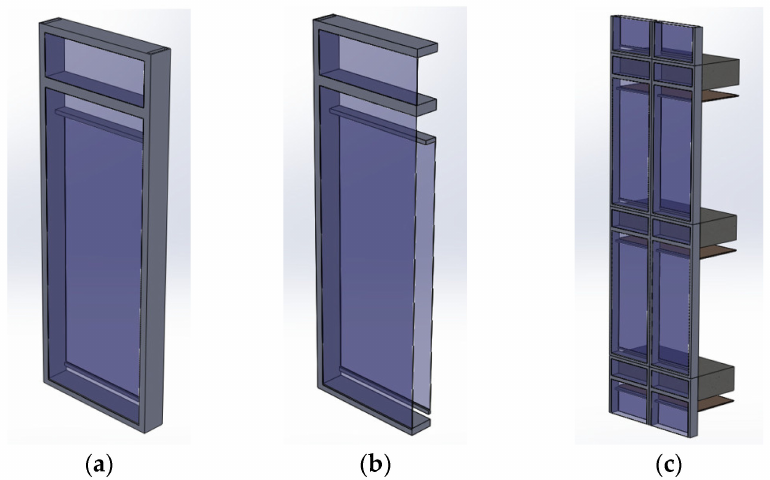
Figure 4. Unitized DSF 3D rendering: ( a ) Single Unitized Unit; ( b ) a cross section of a unit showing glazing and mullion composition; ( c ) Series of units in a curtain